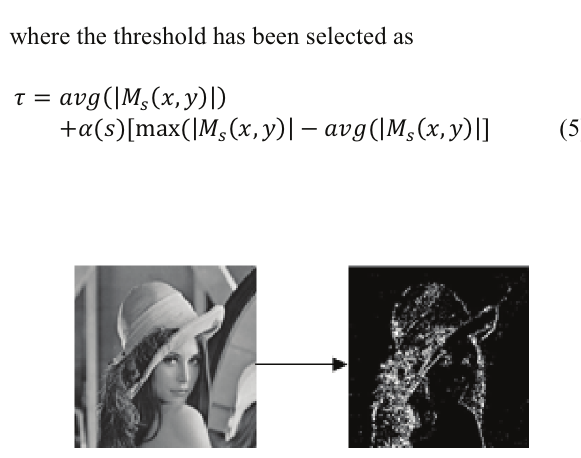
Figure 2: (a) Original Image (b) Wavelet based